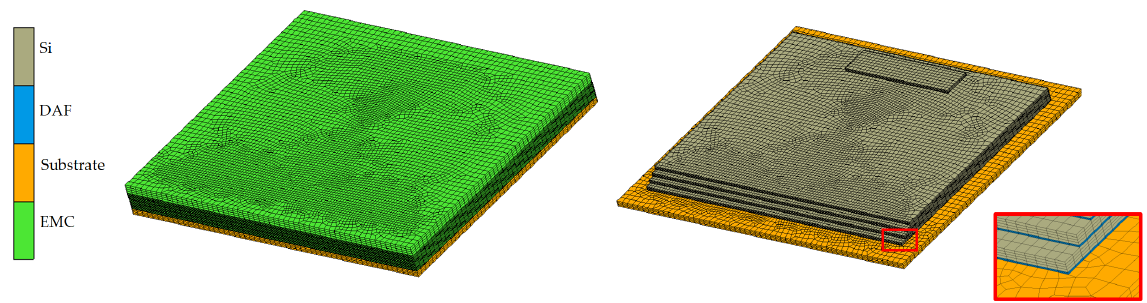
Figure 9. Package material properties and FE